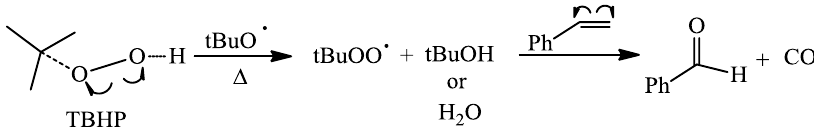
Figure 8. Oxidation effect. Exhaustion of the oxidizing agent with styrene TBHP 75 °C, in presence of catalyst.